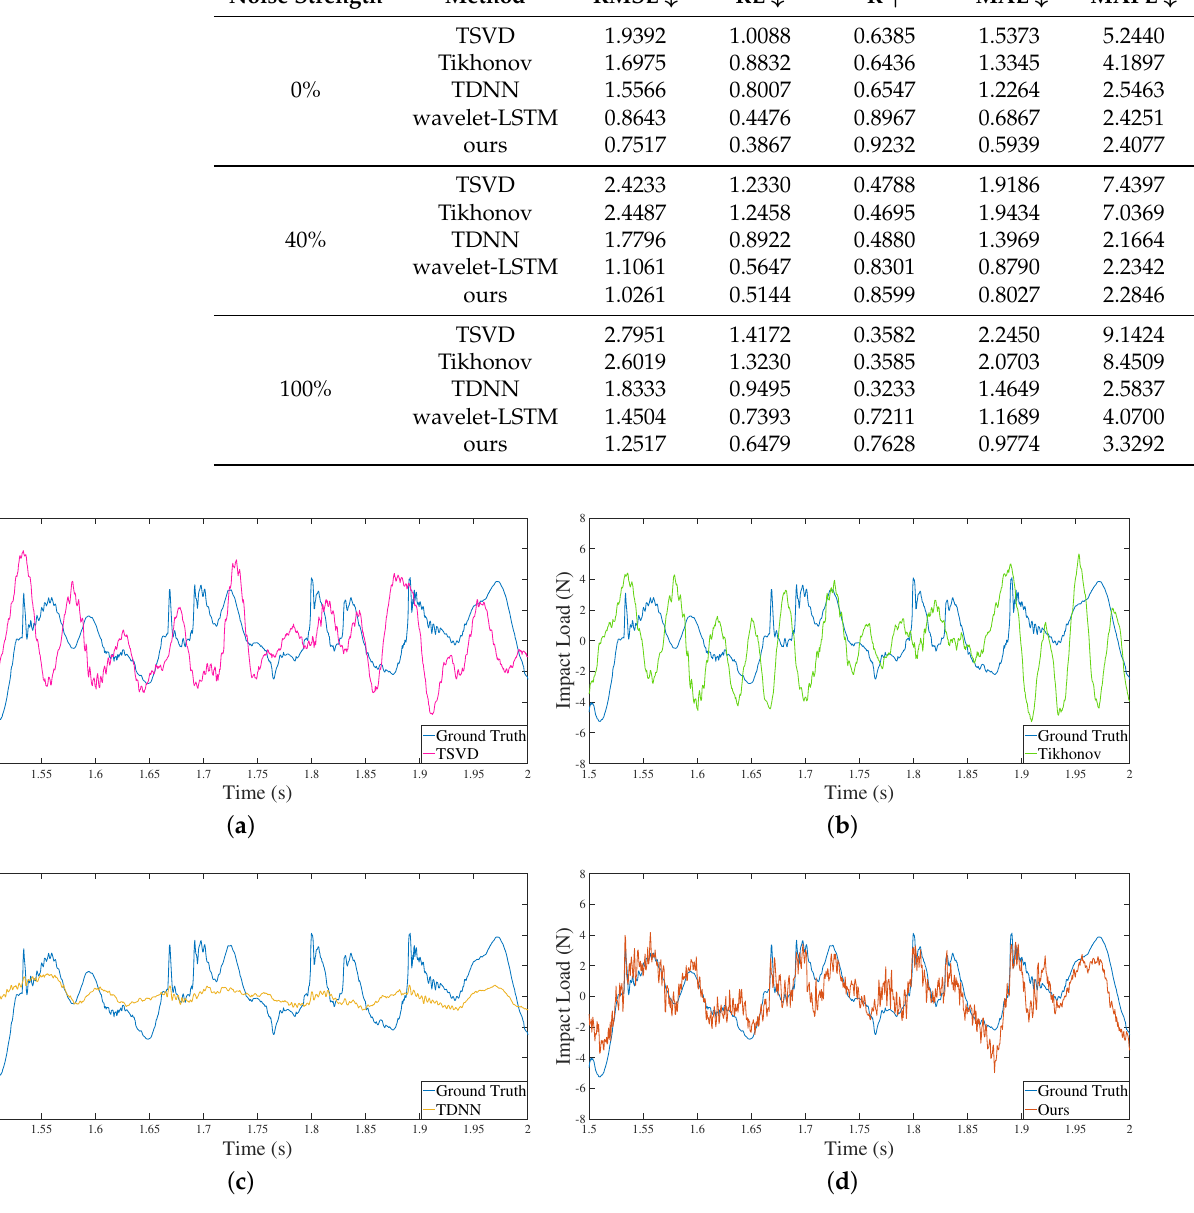
Figure 8. The identified dynamic loads and the ground truth values for different input time windows. Four different time windows are utilized in this experiment. The noise strength is 100% in this ex- ample. ( a ) Comparisons of the estimated loads using TSVD method (magenta) with respect to the ground truths (blue). ( b ) Comparisons of the estimated loads using Tikhonov method (green) with respect to the ground truths (blue). ( c ) Comparisons of the estimated loads using TDNN method (yellow) with respect to the ground truths (blue). ( d ) Comparisons of the estimated loads using the proposed method (red) with respect to the ground truths